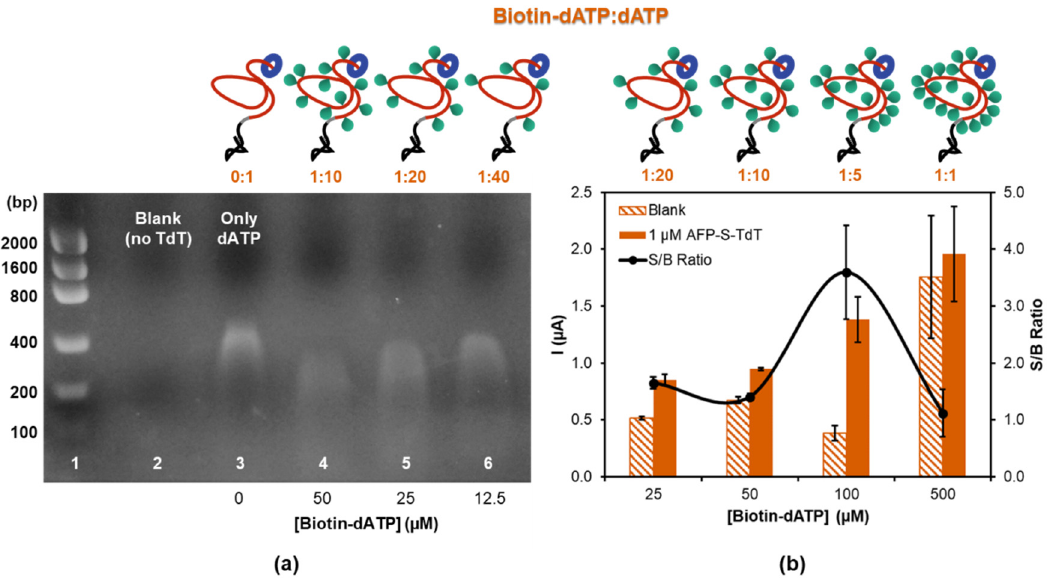
Figure 2. ( a ) Agarose gel electrophoresis of TdT elongation of short aptamer. Lane 1: DNA ladder. Lane 2: TdT blank. TdT elongated product obtained with Lane 3: 100% dATP. Lane 4: 10% biotin-dATP. Lane 5: 5% biotin-dATP. Lane 6: 2.5% biotin-dATP. ( b ) Current obtained in the electrochemical assay with di ff erent biotin-dATP:dATP ratios in the absence (blank, striped bars) and in the presence of the short aptamer at 1 µ M (solid bars) and the corresponding signal-to-blank (S / B) ratio for each condition.